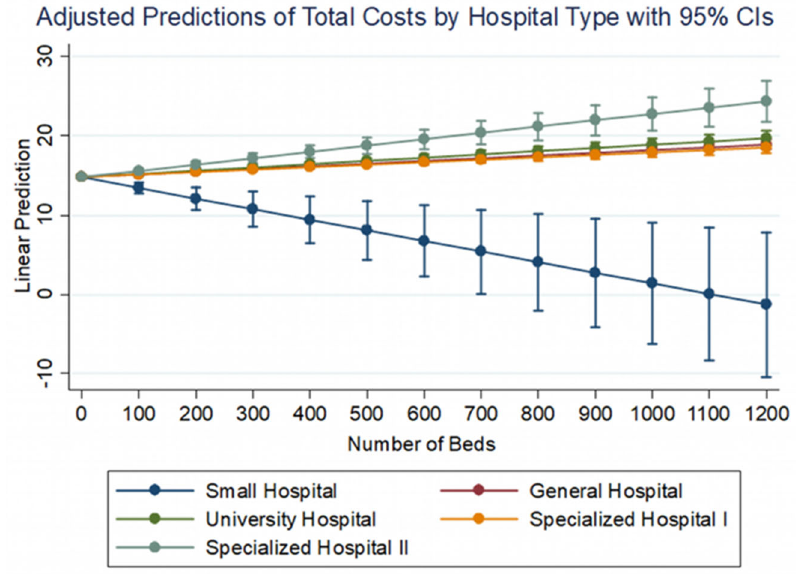
Figure 2. The impact of extra beds on total hospital costs for each type of hospital.